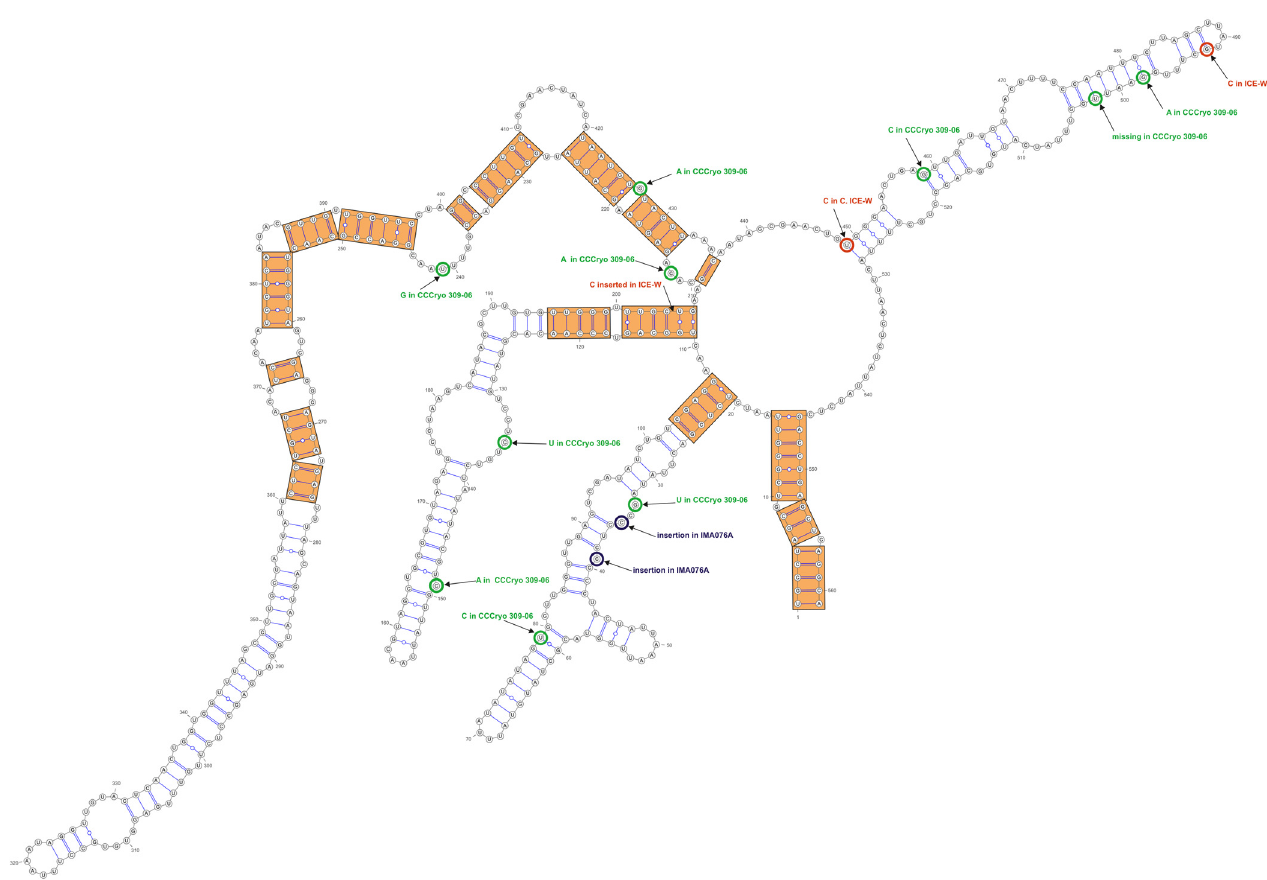
Figure 3. Hypothetical secondary structure of the ITS-2 spacer for Microglena antarctica sp. nov. The nucleotide sequences of the spacers between the four main helices are reported on the structure. A-U pairings are represented with a single line, G-C pairings with a double line, and unconventional pairings with a line interrupted by a circle. Orange boxes include the barcode regions. Nucleotide differences between M. antarctica IMA076A and other strains of the same species are represented by coloured circles (light green for strain CCCryo 309-06, red for strain ICE-W and blue for insertion detected only in IMA076A). Table 2. ITS-2 DNA Barcode of the Microglena species. Base-pair alignment is coded using a number for each base-pair (1 = A-U, 2 = U-A, 3 = G-C, 4 = C-G, 5 = G•U, 6 = U•G, 7 = mismatch and 8 = deletion, unpaired of single bases). ★ = M. opisthopyren [12], ● = M. media [12]. * = non-homoplasious synaphomorphies. ** = 2 non-homoplasious synaphomorphies .